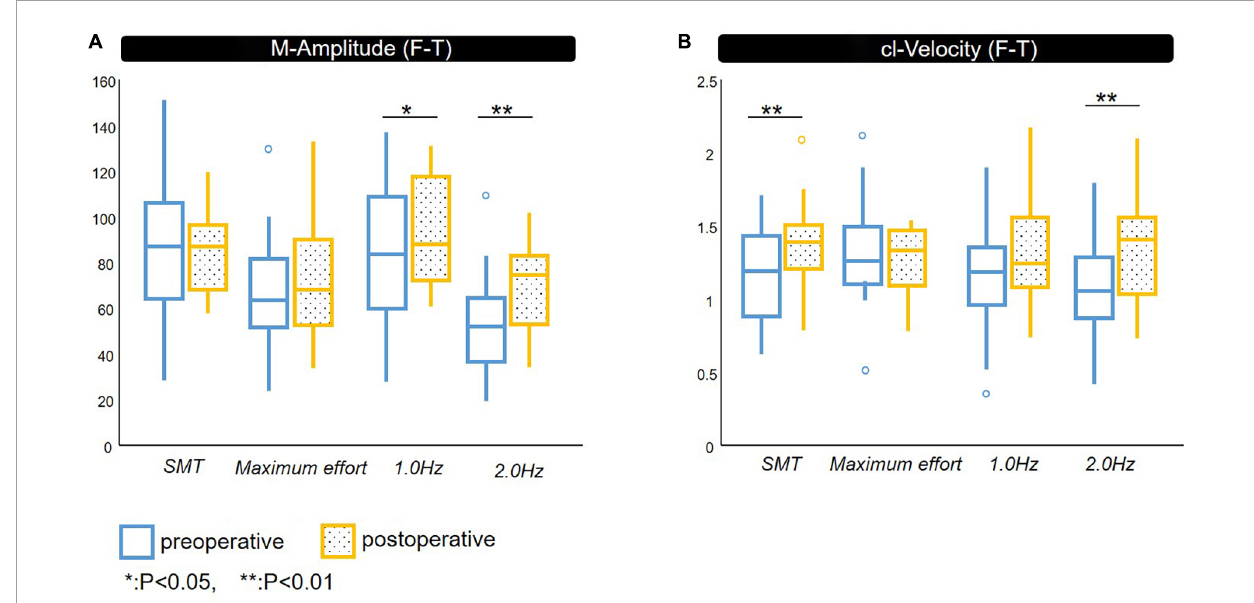
FIGURE2 Spatiotemporal parameters of F-T. Comparison between pre- and post-shunt surgery with definite iNPH. (A) M-Amplitude of finger tapping, (B) cl-Velocity of finger tapping. preoperative, postoperative. iNPH, idiopathic normal pressure hydrocephalus; M-Amplitude, the mean of maximum amplitude; cl-Velocity, the line represents median values; * p < 0.05, ** p < 0.01.